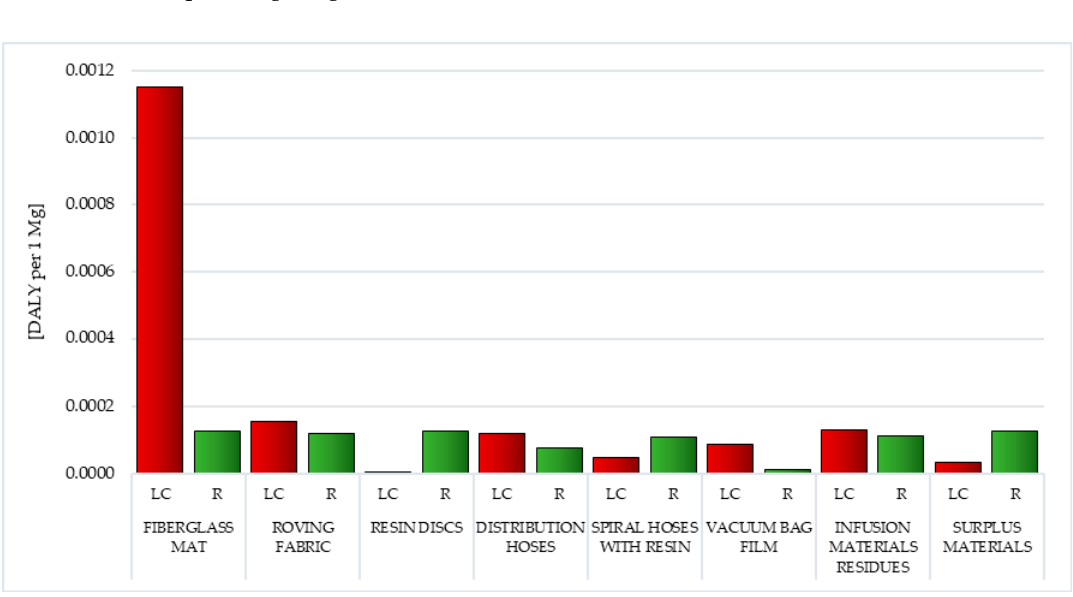
Figure 4. Characterization results of environmental consequences for carcinogens present in selected postproduction waste of wind power plant blades: LC—life cycle, R—recycling [unit: DALY per 1